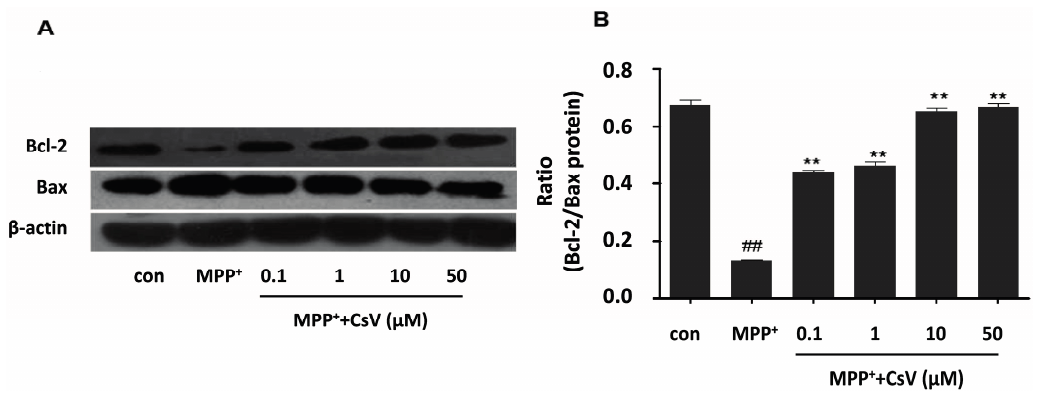
Figure 6. CsV reversed MPP + -induced apoptosis in SH-SY5Y cells. ( A ) Western blot analysis of Bcl-2 and Bax; and ( B ) Data quantification of panel ( A ), Western blot was quantified and expressed as the ratio of Bcl-2/Bax intensity. ## p < 0.01 vs. control group, ** p < 0.01 vs. MPP + treated alone. Data are expressed as means ± SD ( n =